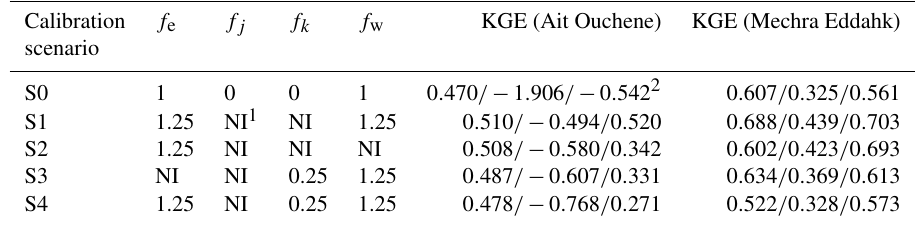
Table 4. Parameter identifiability values and optimal values for each calibration scenario.